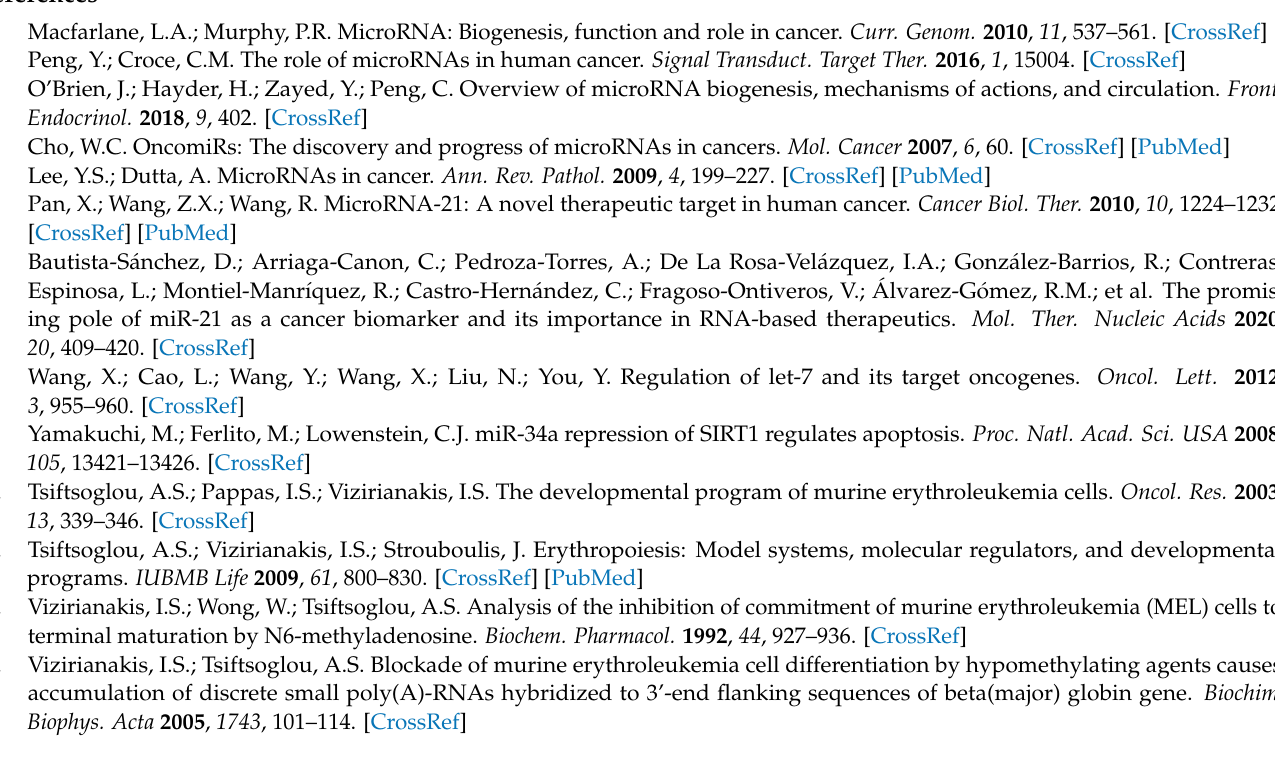
Supplementary Materials: The following are available online at https://www.mdpi.com/1424-8 247/14/2/137/s1, Figure S1: MEL cells as a model of erythroleukemia differentiation. Figure S2: miRNA relative levels in untreated MEL cells. Figure S3: Electrophoresis of the amplified products generated during the qRT-PCR experiment in Figure 1. Figure S4: Analysis of the transfection efficiency of GFP and miR-16-5p mimic plasmids. Figure S5: miR-16-5p overexpression inhibits cell proliferation of various cancer cell lines. Figure S6: Venn diagram comparing the genes targeted by miR-16-5p according to three online platforms (miRTargetLink, miRNet, miRwalk). Table S1: The 20 most significant pathways affected by miR-16-5p retrieved through miRNet (miRNet functional enrichment tool). Table S2: The 20 most significant pathways affected by miR-16-5p retrieved through miRTargetLink. Table S3: miRNA and mRNA primers used for the qRT-PCR assays in the study. Supplementary Excel File: Analysis of miR-16-5p target